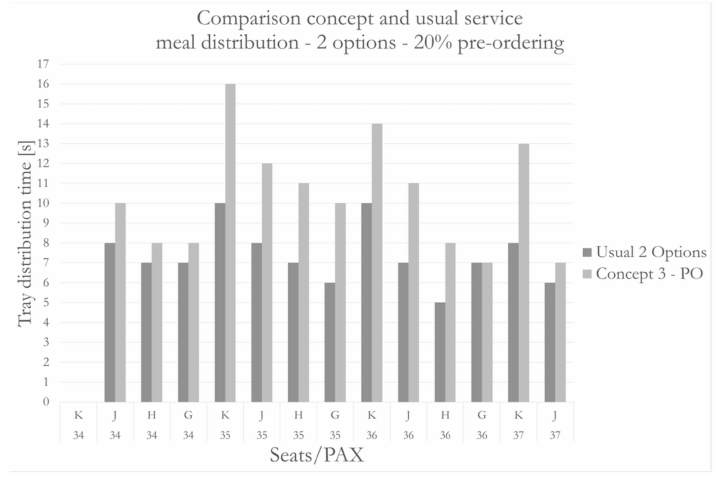
Figure 25. Meal service distribution with 20% pre-ordering.